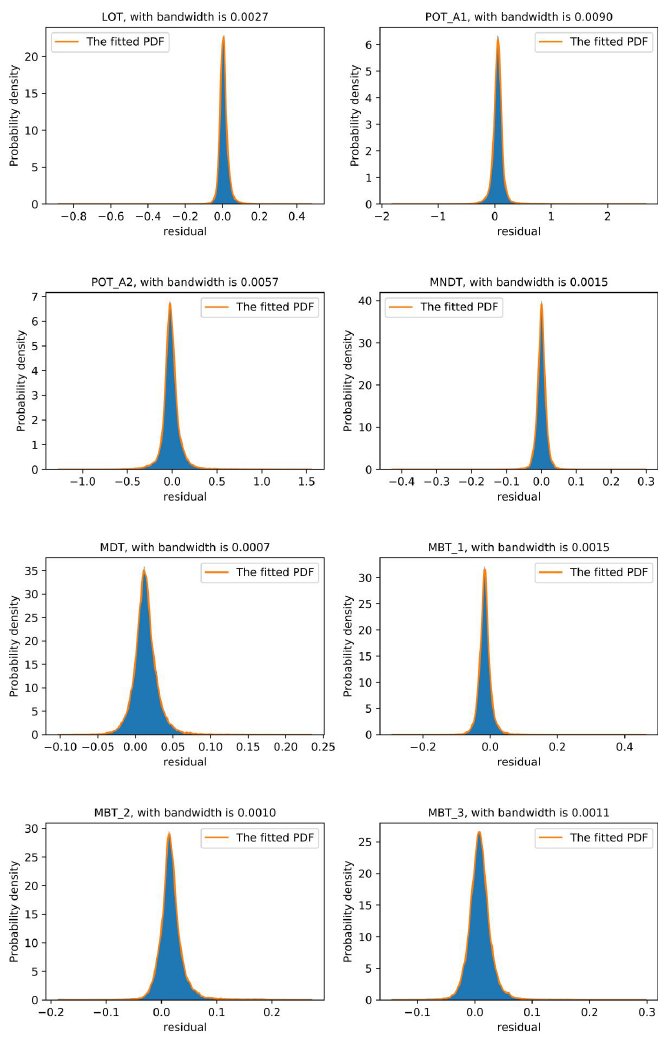
Figure 12. Residual distribution of each variable. Table 3. Reasonable residual ranges of the overall NBM and each